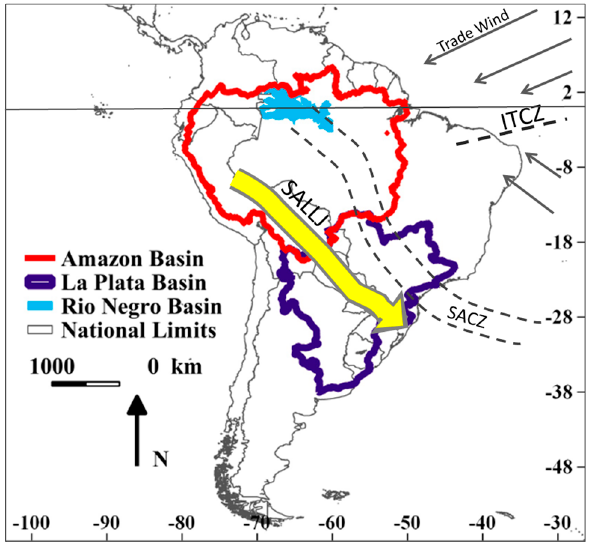
Figure 1. Pattern of the Intertropical Convergence Zone (ITCZ), South Atlantic Convergence Zone (SACZ), South American Low Level Jet (SALLJ) core and northeast and southeast wind trades during the South American Monsoon System from December to February (DJF). Source: V. Michot.